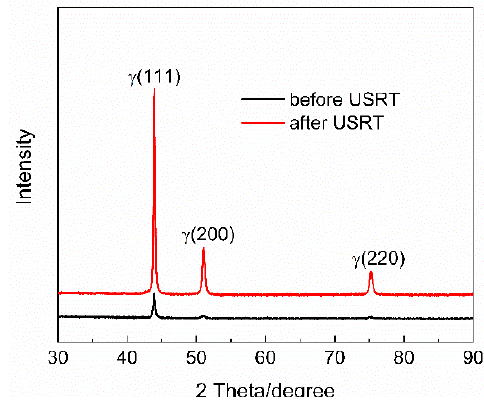
Figure 3. XRD patterns of alloy 690 before and after USRT.